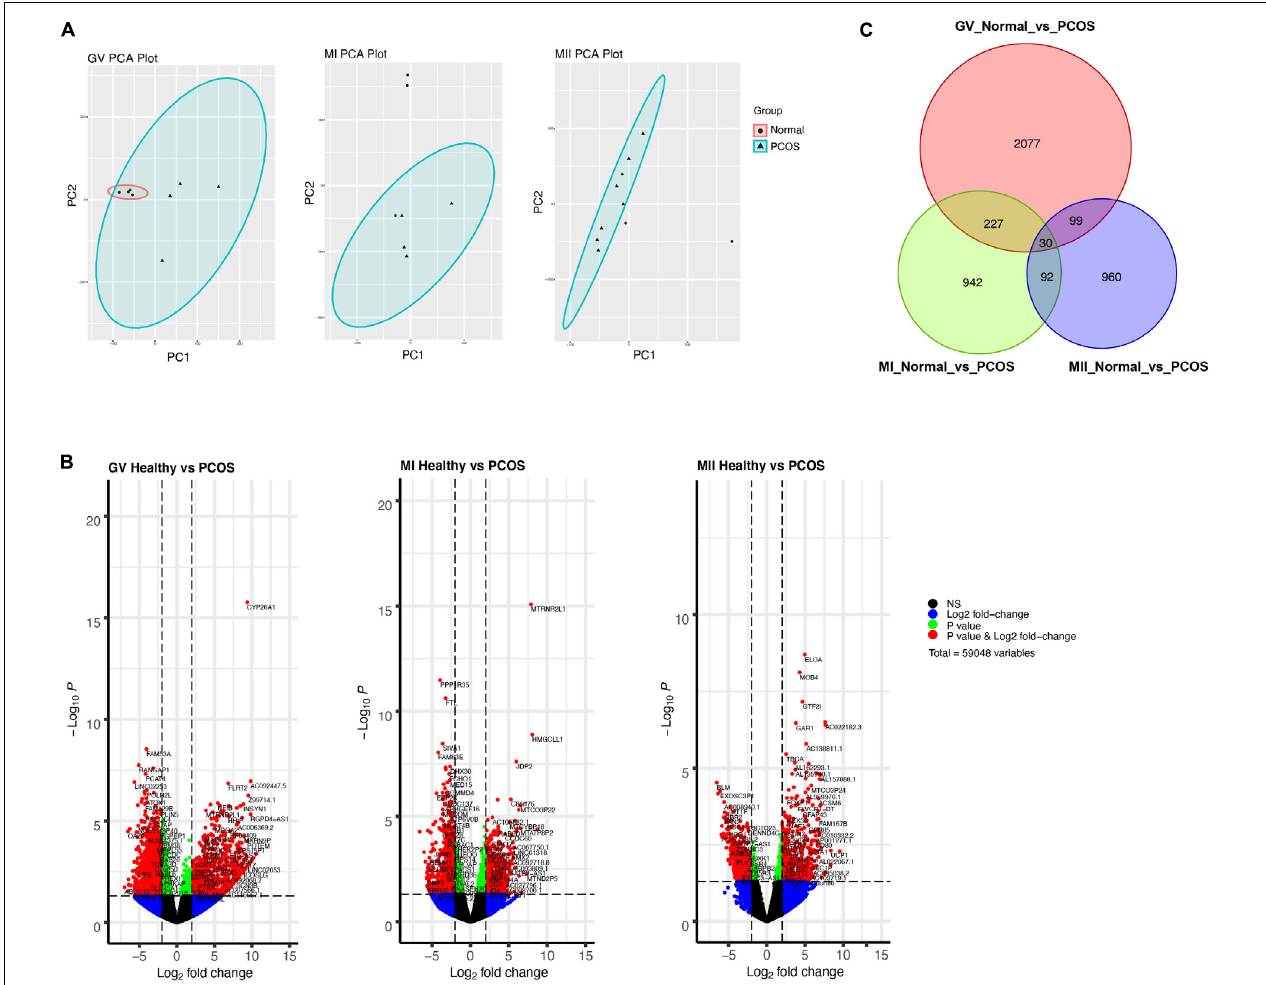
FIGURE 3 | Single-cell RNA-seq transcriptome profiling of healthy and PCOS oocytes. (A) PCA plot of single-cell transcriptomes at GV (left) , MI (middle), and MII (right) stage. (B) Volcano plot shows significant DEGs of oocytes in GV (left) , MI (middle) , MII (right) stage between healthy and PCOS group. (C) Venn diagram shows the overlap of the DEGs in different